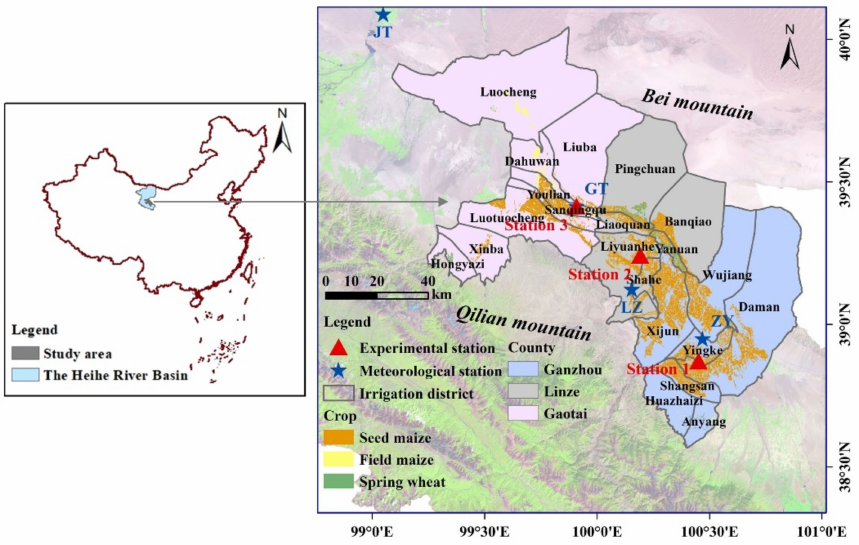
Figure 1. Location, irrigation districts, and staple crops of the study area. Sites of meteorological stations and experimental stations are